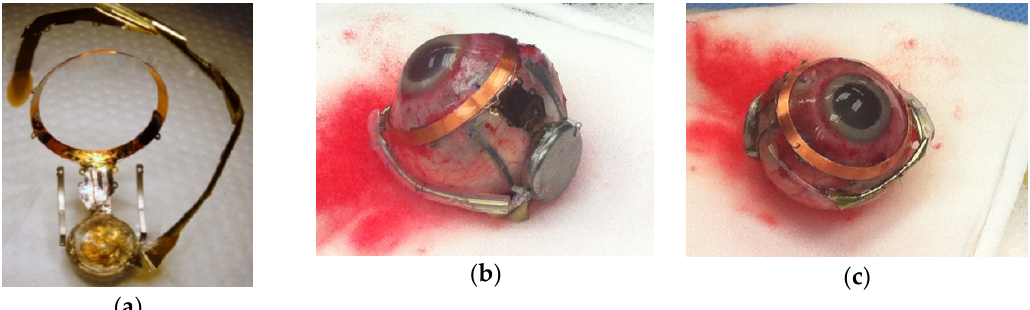
Figure 4. Photographs of the implanted components of our prosthesis. ( a ) A previous-generation coiled-cable electrode array that accommodated a variable distance between the implanted neuro-stimulator package and the insertion site into the sub-retinal space. A flexible, 12 μm-thick array is helically wound around a medical grade silicone tube; ( b , c ) The same generation device is shown implanted around a human cadaver eye after its enucleation. Note, the eye shrinks in size post mortem , thus the prosthesis fit in this example is not exemplary of what the appearance of the fit would be for a living subject that had the same ocular size pre-operatively.